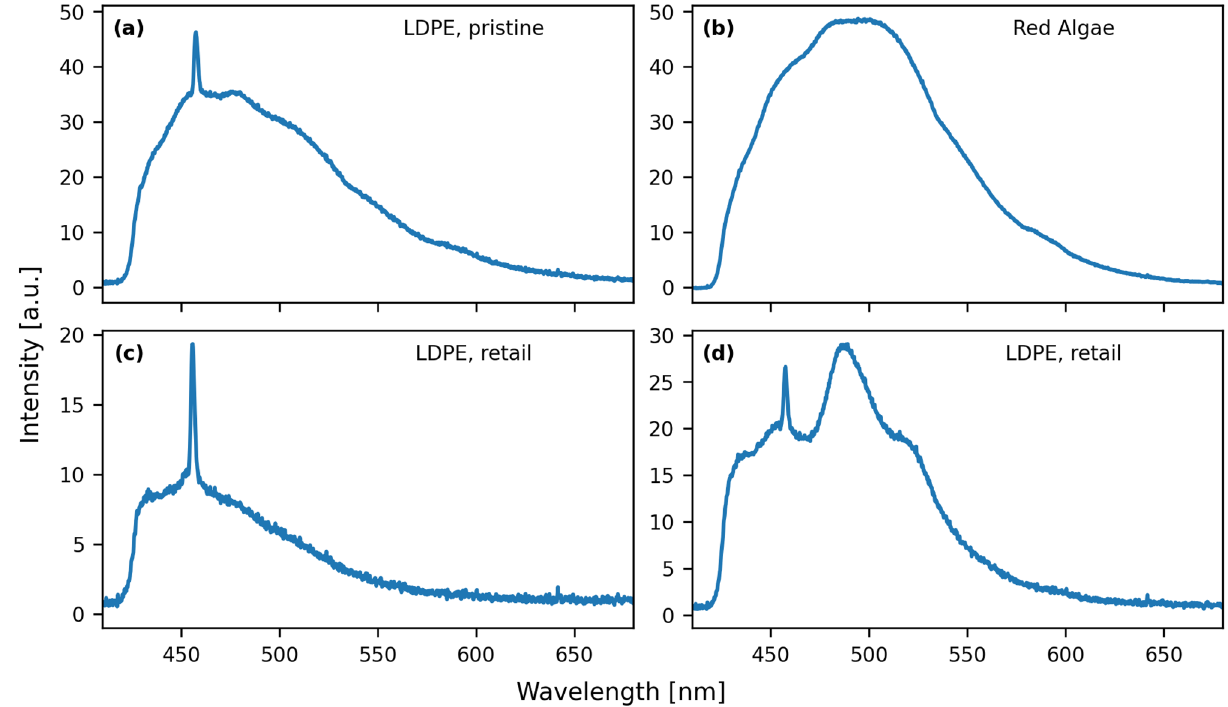
Figure 1. A representative selection of PL spectra of samples used in this study. The spectra correspond to ( a ): pristine LDPE, ( b ): red algae and ( c , d ): a consumer product made of LDPE. The spectra in ( c , d ) correspond to the same sample but were acquired with different alignments of the setup components, laser power values, and exposure